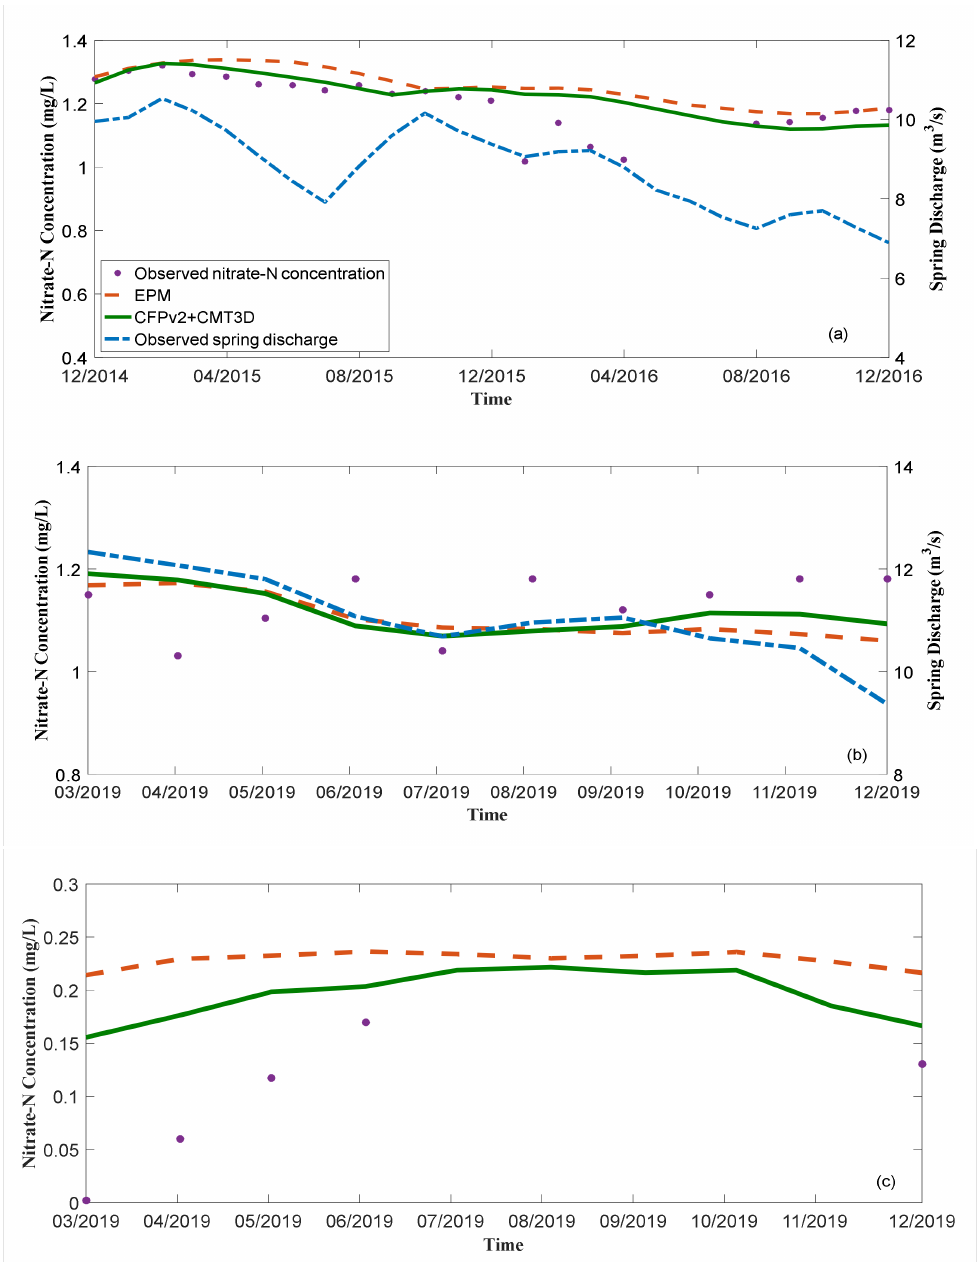
Figure 9. Simulated nitrate concentration in the discharge of Silver Springs for the periods ( a ) January 2014–December 2016 and ( b ) March 2019–December 2019; ( c ) simulated nitrate con- centration in a monitoring well (new drilled well shown in Figure 1c) in City of Ocala, FL, USA. December 2014–December 2015 and January 2016–December 2016 are the calibration and validation periods for the transport model, respectively. Nitrate concentrations were both sampled at the discharge of Silver Sprigs main vent and the new drilled well (shown in Figure 1c) from March 2019–December 2019 to investigate the effects of conduit flow to model